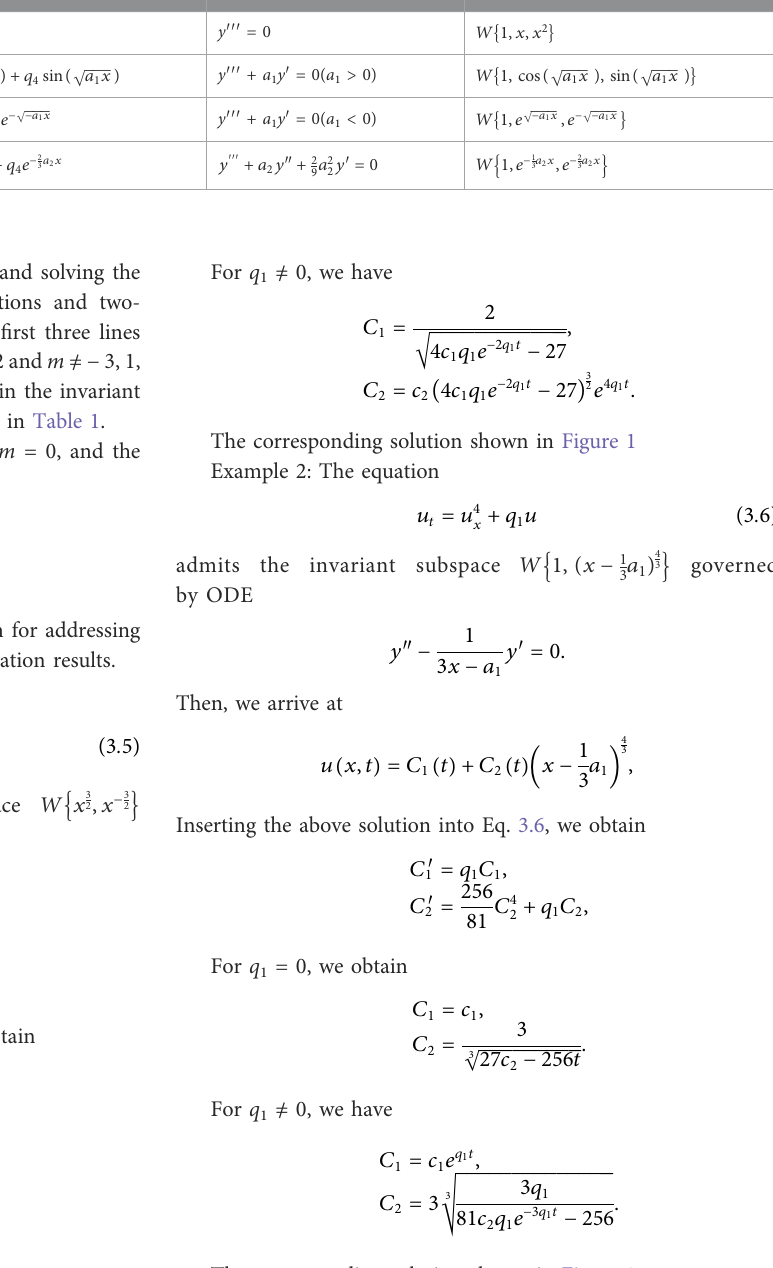
TABLE 2 Classi fi cations of W 3 governed by linear ODEs (2.3) of Eq. 1.1.